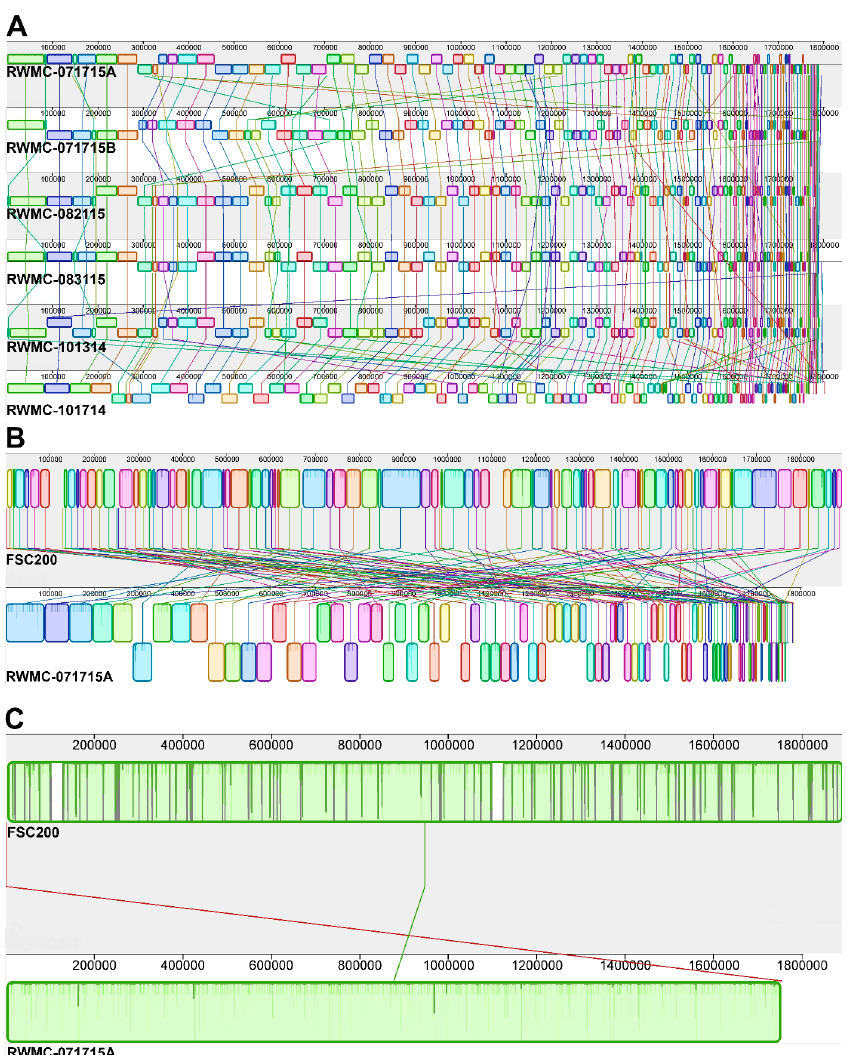
Figure 1. Diagram depicting local collinear blocks (LCBs) within the genomes of the six wild-type F. tularensis type B isolates compared to the reference type B strain FSC200. ( A ) Comparison of the LCBs obtained for F. tularensis strains RWMC-071715A, RWMC-071715B, RWMC-082115, RWMC-083115, RWMC-101314, and RWMC-101714. ( B ), ( C ) Comparison of the LCBs for a representative F. tularensis type B strain (RWMC-071715A) with the reference type B strain FSC200 (NCBI reference sequence NC_019551.1, GenBank accession number CP003862), before and after contig correlation to FSC200, respectively. The large white LCBs in FSC200 denote missing WGS data in RWMC-071715A in Figure 1C. These regions at nucleotide positions 100,370–129,503 and 1,096,979 − 1,126,076 in FSC200 contained two additional copies of the genes encoding 16S ribosomal RNA (rRNA), 23S rRNA, 5S rRNA, and transfer RNA, as well as insertion sequence elements and hypothetical genes. Contigs less than 128 bp were not included in the comparison to FSC200 in Figure 1B,C. Each LCB is represented with a di ff erent pattern and / or shading. An LCB depicted below the center line indicates that the sequence is reverse / complement, and the relative nucleotide lengths are denoted in base pairs above the corresponding genome. The progressiveMauve software tool was used to align the genomes